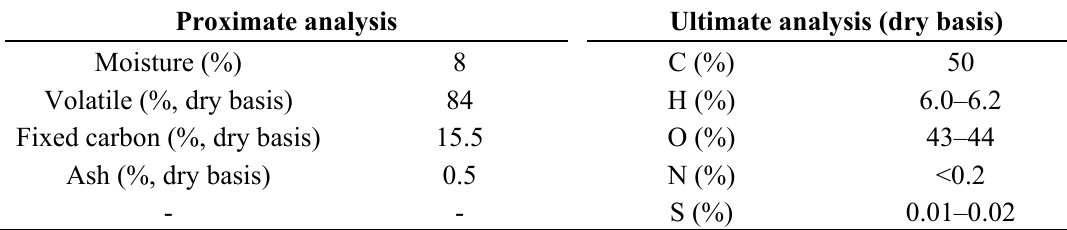
Table 1. Characterization of the biomass feedstock.